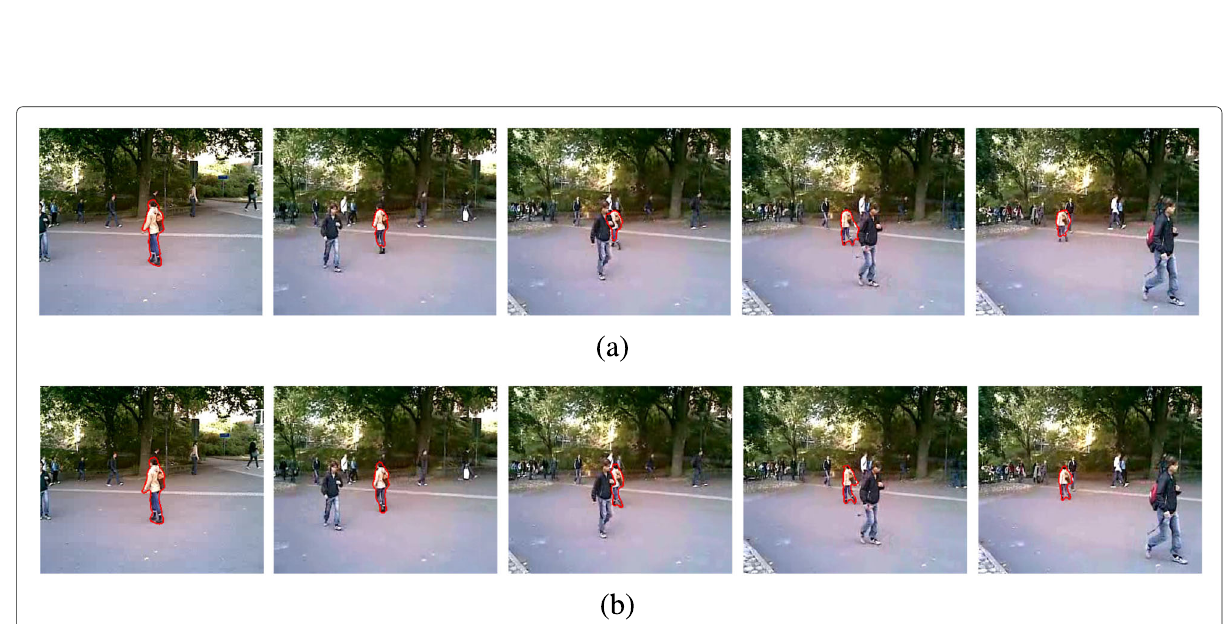
Fig. 5 Tracking results on highjump sequence for frames of 0, 13, 27, 39, and 64. a Standard mean shift [8]. b The method in [34]. c The proposed method